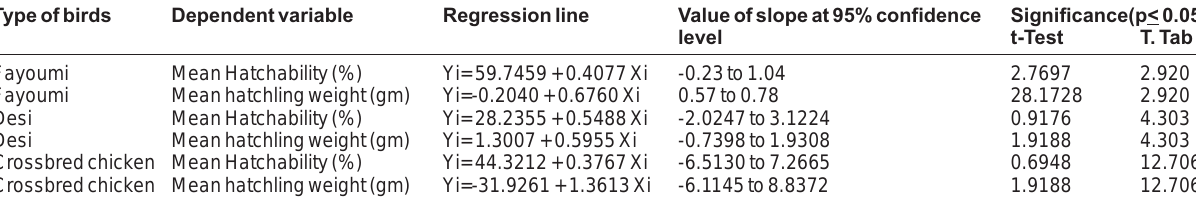
Table-2. Regression analysis showing mean hatchability and hatchling weight and as affected by mean egg weight (independent variable) Type of